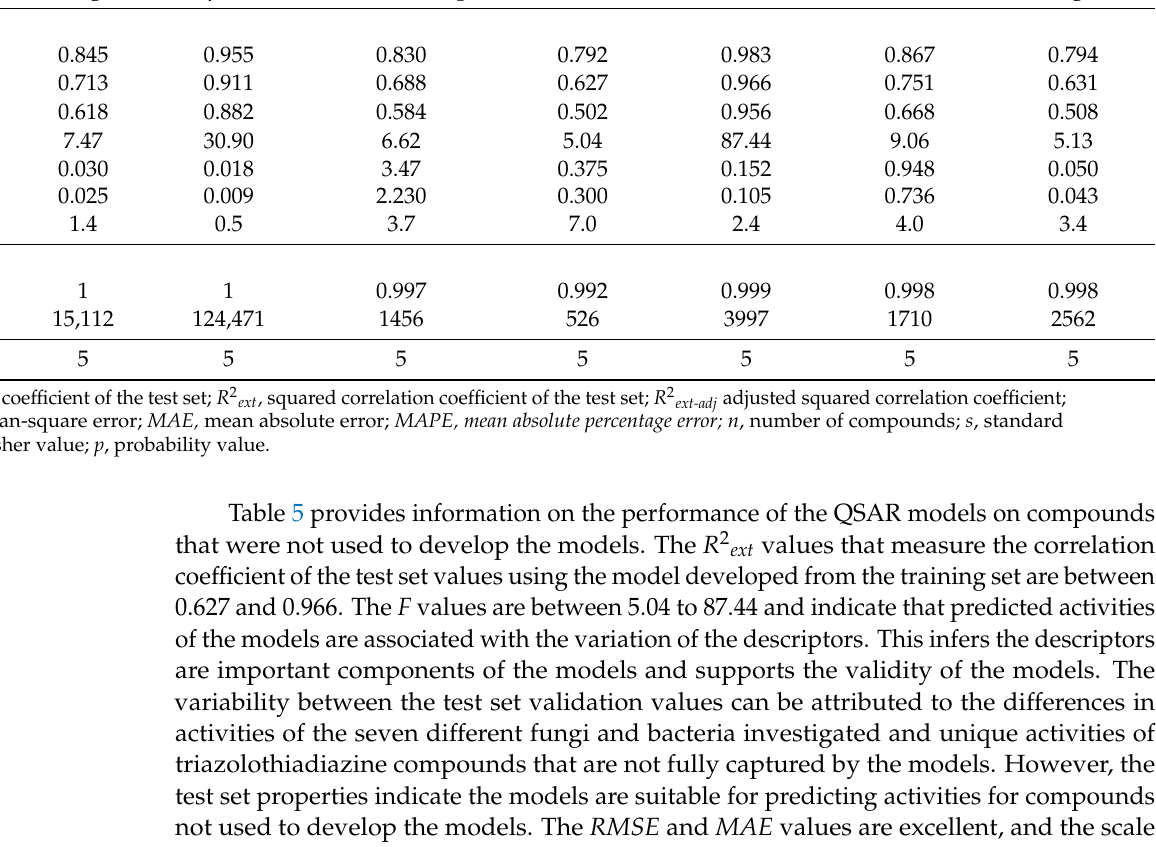
mean absolute percentage error ( MAPE ) permits the comparison of the mean absolute error across varying activities and is between 0.5 and 7.0% for the compounds evaluated.